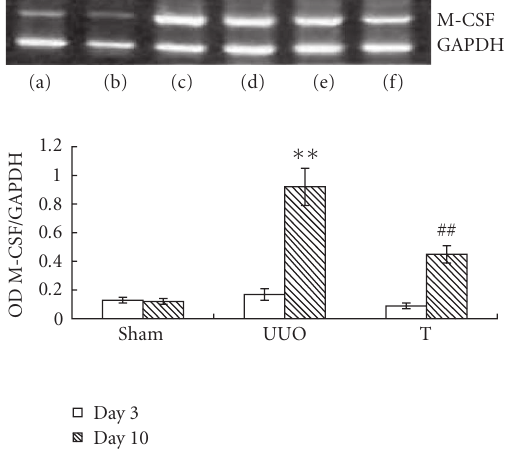
Figure 7: Expression of M-CSF at di ff erent time points in di ff erent groups by RT-PCR. Total RNA was extracted from kidney tissue at the indicated time and reverse-transcribed to cDNA. cDNA was subject to PCR, and M-CSF was amplified to 234 bp fragments. GAPDH was used as internal control (a) on day 3 in sham group, (b) on day 10 in sham group, (c) on day 3 in UUO group, (d) on day 10 in UUO group; (e) on day 3 in treatment group, and (f) on day 10 in treatment group. ∗∗ : P < . 01 versus sham group of the same time point. ##: P < . 01 versus UUO group of the same time point.